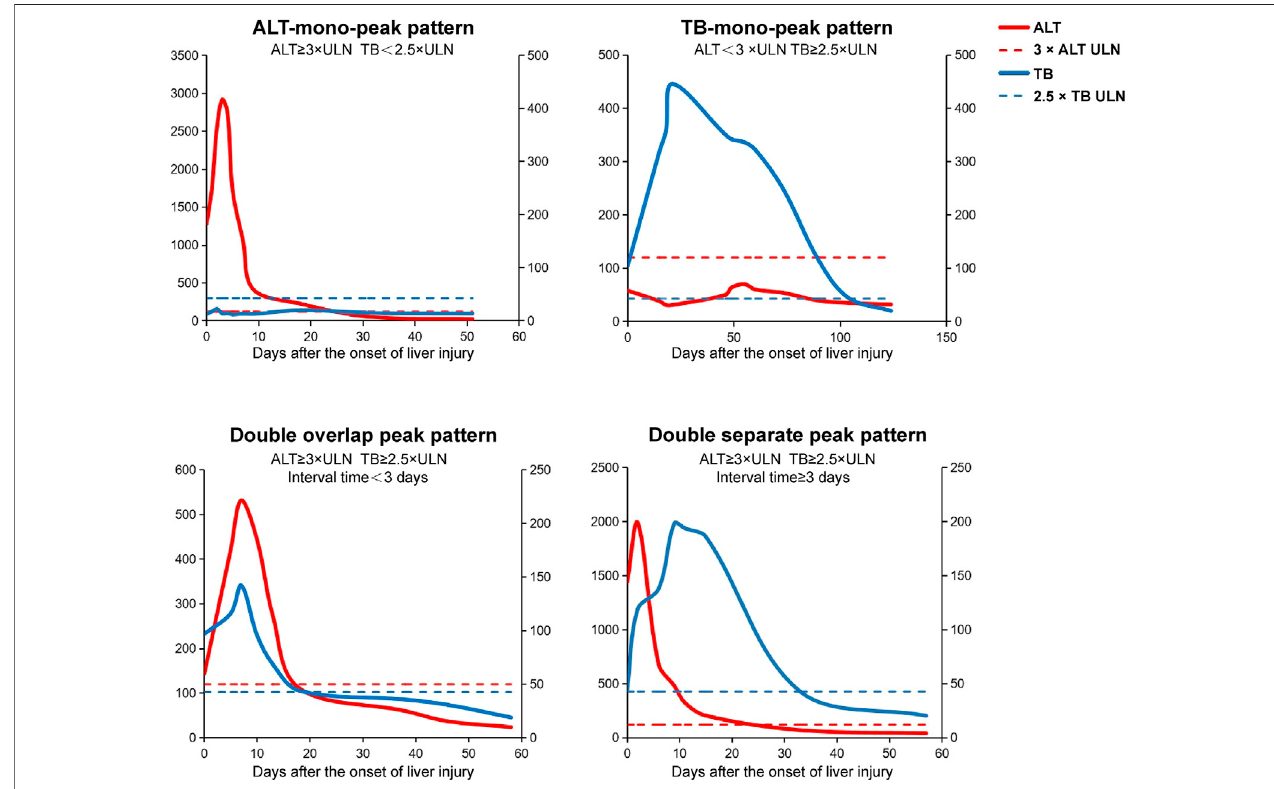
FIGURE 1 | Schematic diagram of the four different dynamic evolution patterns of ALT and TB in DILI. The ALT-TB dynamic evolution pattern is de fi ned as the following four patterns: (1) ALT-mono-peak pattern, ALT ≥ 3×ULN, and TB < 2.5×ULN; (2) TB-mono-peak pattern, ALT < 3×ULN and TB ≥ 2.5×ULN; (3) ALT and TB doubleoverlap peak pattern, ALT ≥ 3×ULN and TB ≥ 2.5×ULN, and the time interval between ALT and TB peak < 3 days; (4) ALT and TB double separate peak pattern, ALT ≥ 3×ULN and TB ≥ 2.5×ULN, and the time interval between ALT and TB peaks ≥ 3 days. Abbreviations: DILI, drug-induced liver injury; ALT, alanine aminotransferase; TB, total